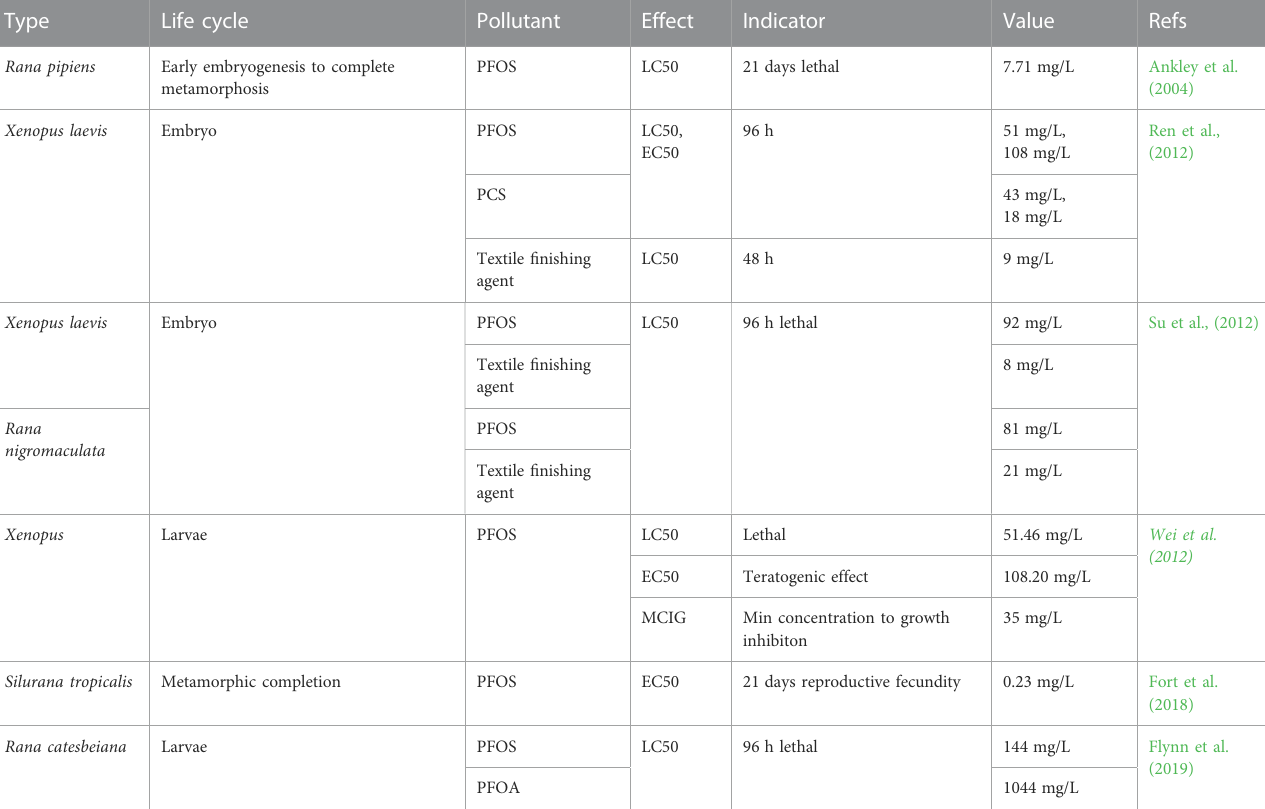
TABLE 3 EC50/LC50 values of target PFASs on